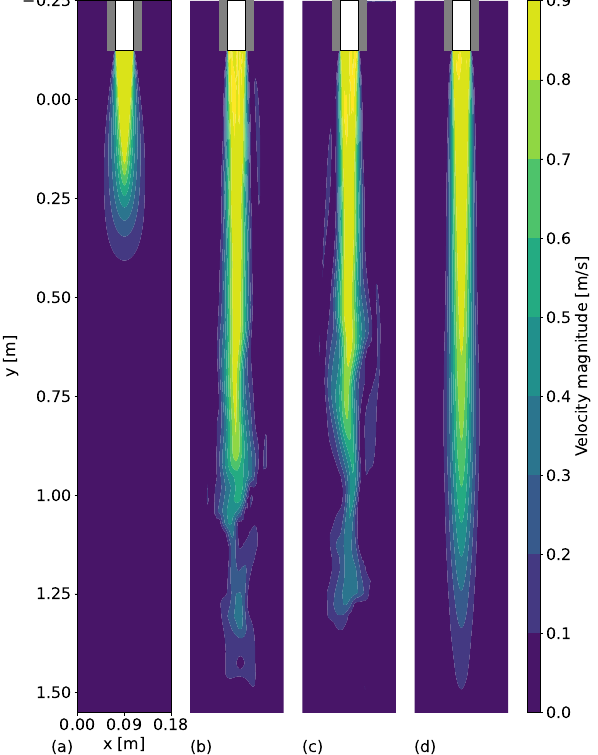
Figure 15. Velocity magnitude field at VA2. ( a ) k − ε model; steady-state; ( b ) LES model at t 1 = 205 s; ( c ) LES model at t 2 = 1096 s; ( d ) LES model; time-average.